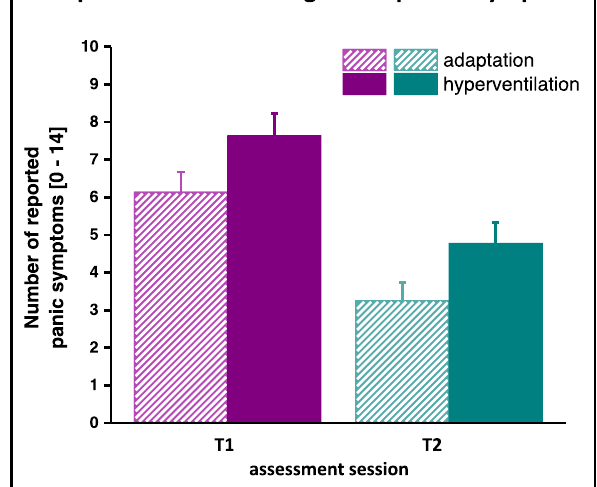
Fig. 2 Manipulation check: changes in reported panic symptoms from the adaptation phase to the hyperventilation phase. Means and standard errors of the number of reported panic symptoms during adaptation and hyperventilation at T1 and T2,